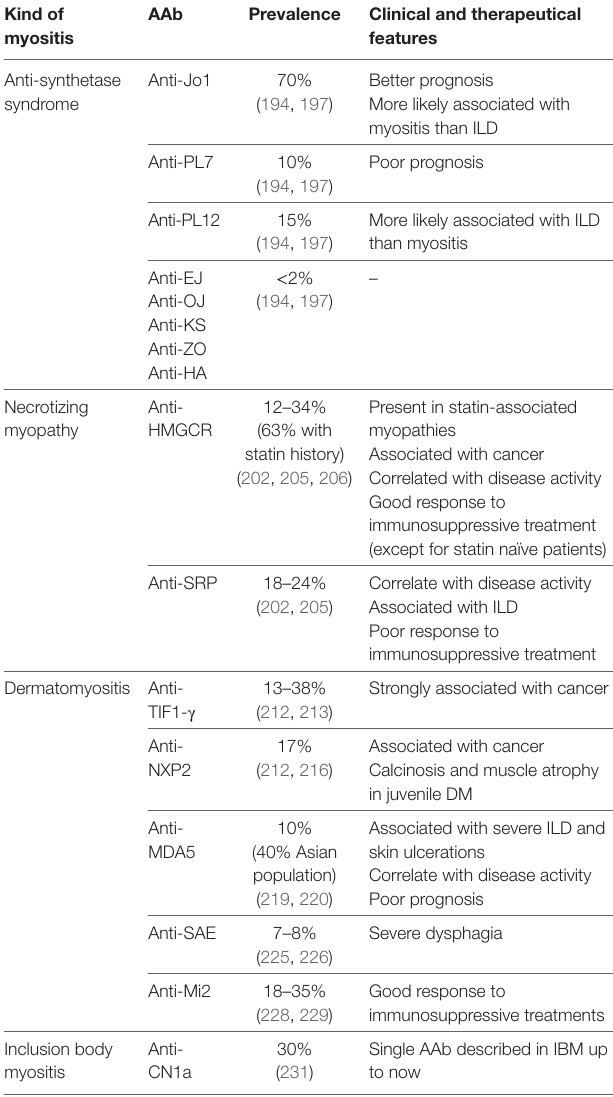
TAble 5 | AAb associated with myositis [antisynthetase syndrome (ASS), necrotizing myopathy (NM), dermatomyositis (DM), and inclusion body myositis